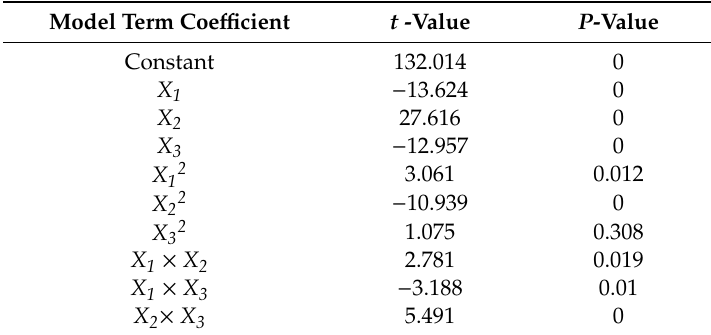
Table 4. Estimated corresponding t- and P-values of the model term coe ffi